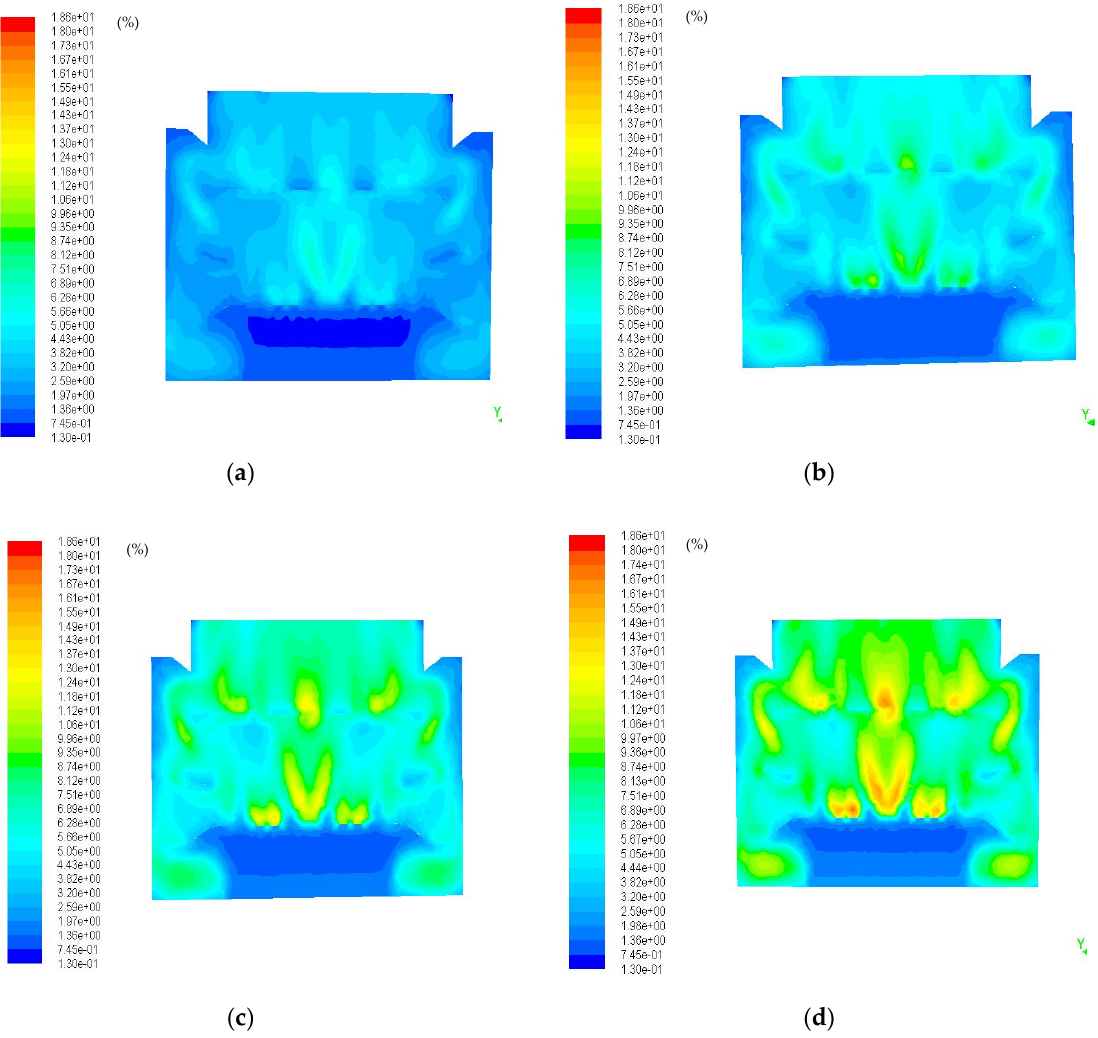
Figure 6. CFD-simulated turbulence intensity (%) changes in non-powered hydraulic mixing with different inlet velocities. ( a ) Inlet velocity: 0.2 m/s; ( b ) inlet velocity: 0.3 m/s; ( c ) inlet velocity: 0.4 m/s; ( d ) inlet velocity: 0.5 m/s.